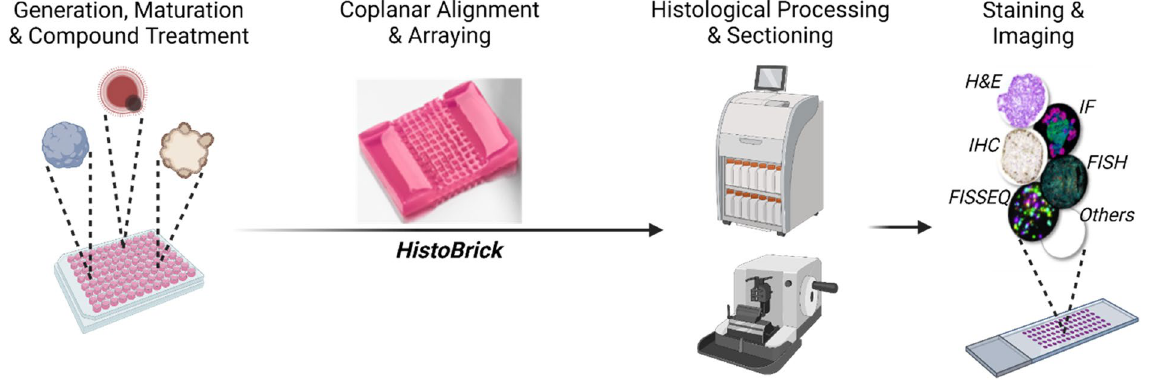
Figure 2. Schematic showing the pipeline of histological analysis on micro-tissues. HistoBrick provides the coplanar alignment and array arrangement needed to bridge 3D cell model production and histological processing towards high-throughput analysis of formalin-fixed and paraffin-embedded sections. Created with BioRender.com.